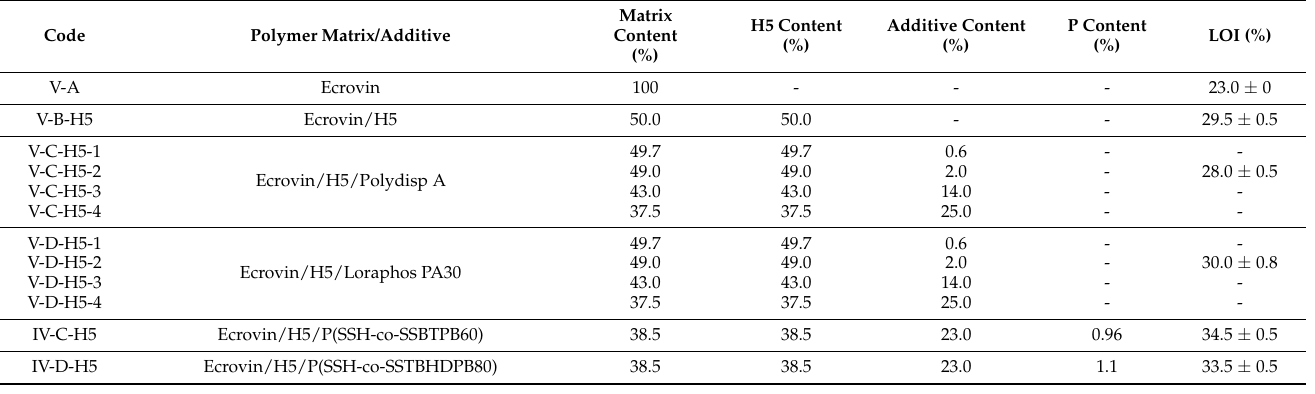
Figure 8. ( a ) TGA measurements and ( b ) the mass loss derivative as a function of temperature for neat H5 and polymer matrix/additive systems: IV-D-H5, III-E-H5, III-E-H6 and II-E-H5. Table 9. LOI measurements of Ecrovin ® LV 340 eco blends with H5 and additives.